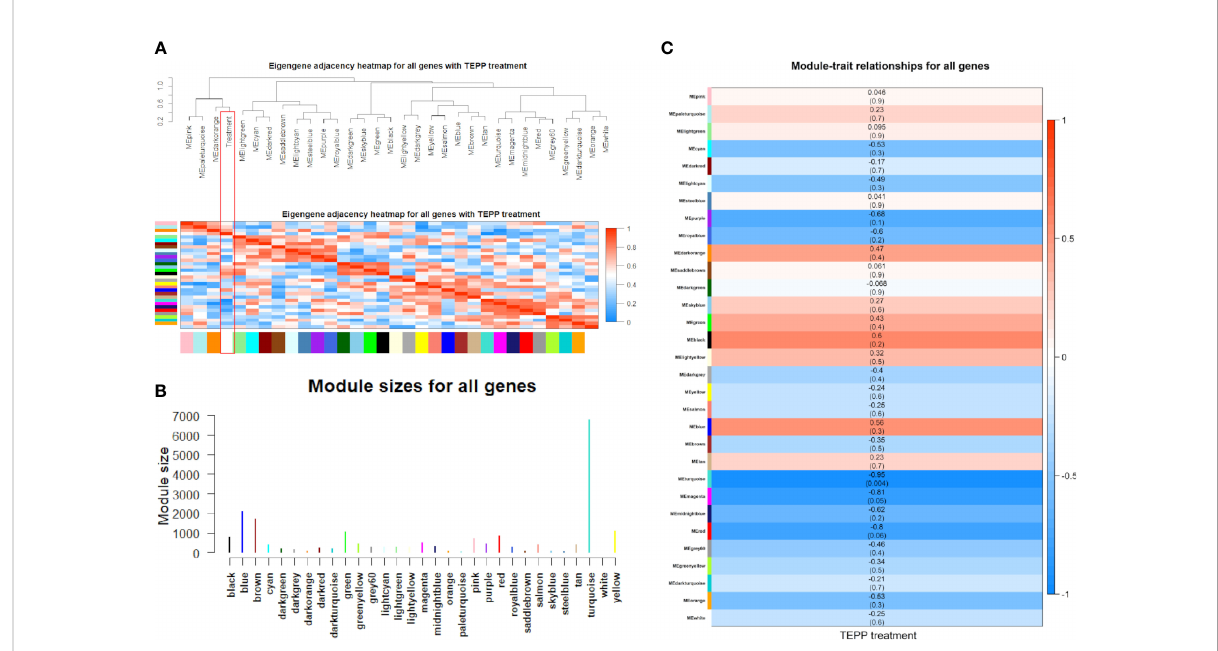
FIGURE 3 Co-expressions of differentially expressed (DE) genes. (A) Eigengene dendrogram and adjacency heat map with TEPP-46 treatment (red rectangle). (B) Module sizes (number of genes) in different colors. (C) Module – TEPP relationship heatmap. Each row indicates module eigengenes with the correlation coef fi cients ( P -values in brackets), where red and blue colors represent positive and negative correlations, respectively.